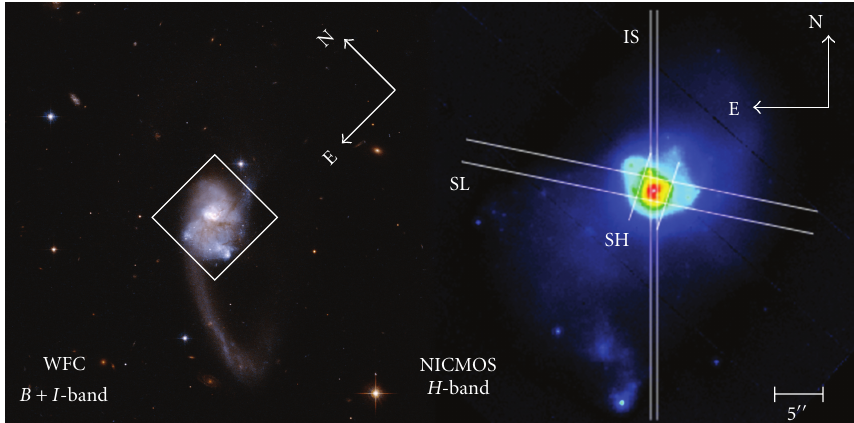
Figure 1: HST images of IRAS 20551-4250. Left: composite B + I band image obtained with the WFC F435W and F814W filters (PID 10592, PI A. Evans). The white square identifies the nuclear (30 (cid:6)(cid:6) × 30 (cid:6)(cid:6) ) region. Right: NICMOS F160W image (PID 11235, PI J. Surace) of the nuclear region. The Spitzer /IRS short-wavelength/low-resolution (SL, 3.6 (cid:6)(cid:6) width) and short-wavelength/high-resolution (SH, 4.7 (cid:6)(cid:6) width) slits are shown together with the VLT /ISAAC slit (IS, 1 (cid:6)(cid:6) width in the L -band). Given a spatial scale of 950 pc/ (cid:6)(cid:6) , the SL, SH, and IS slits cover regions of 3.4 kpc, 4.5 kpc, and 950 pc, respectively.